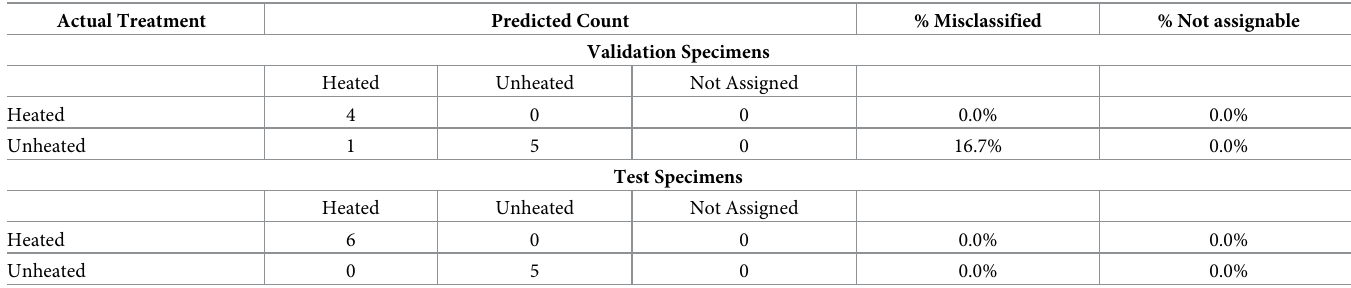
Table 7. k-NN model B specimen-level prediction results.